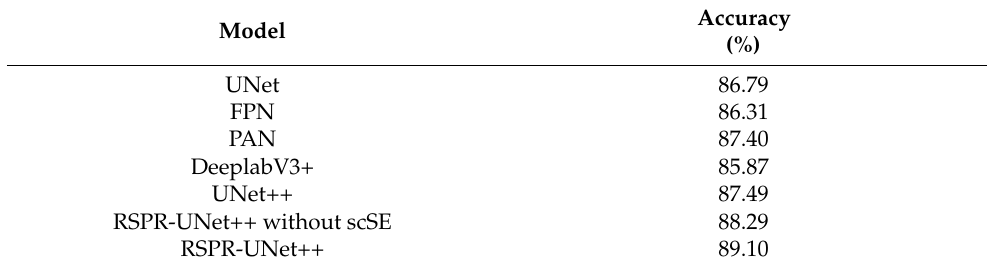
Table 6. The overall accuracy for the segmentation results of the Sentinel-2 image in Figure 9.